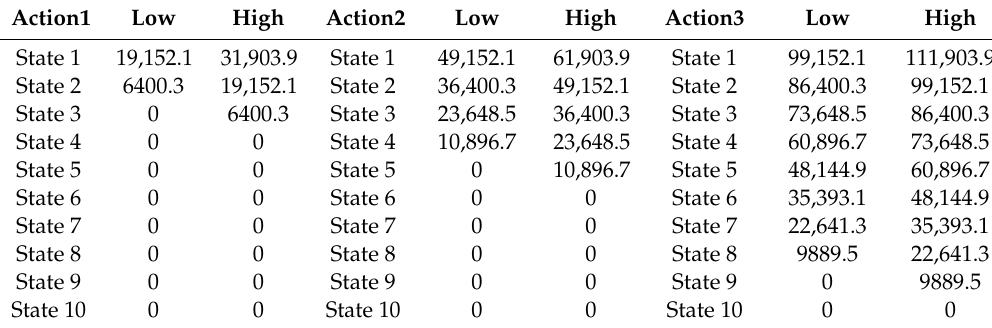
Table 3. Rewards interval for each